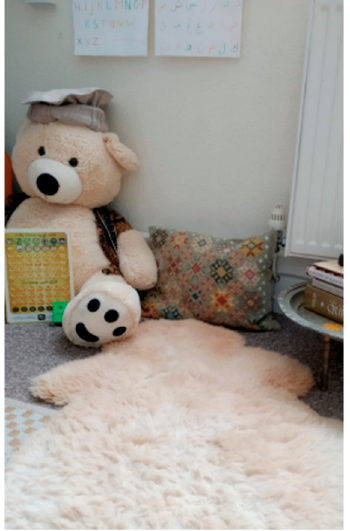
Figure 4. Sumayya’s living room Ramadan corner (Sumayya, Diary Image, Entry 2).